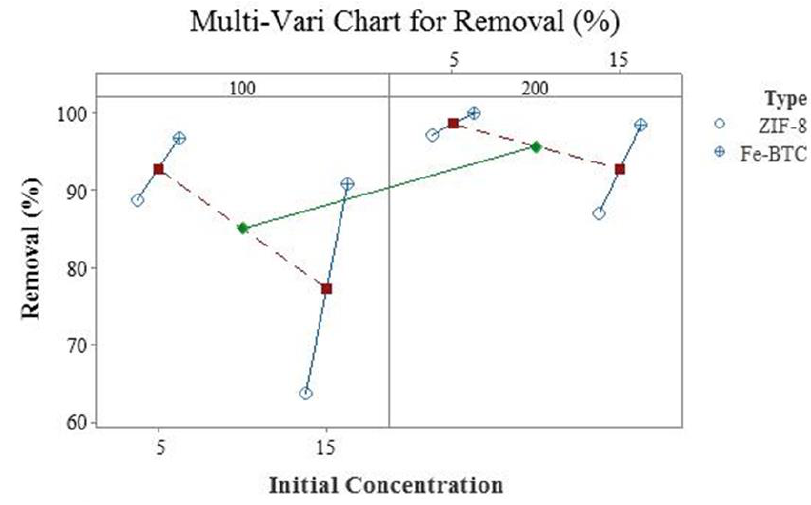
Figure 12. Multi-vari chart plot for MO removal efficiency. The green diamond symbols represent the mean for each level of dosage while the green line connects the dosage level means and the red square symbols correspond to the means for each level of initial concentration while the red-dashed line connects the initial concentration level means.